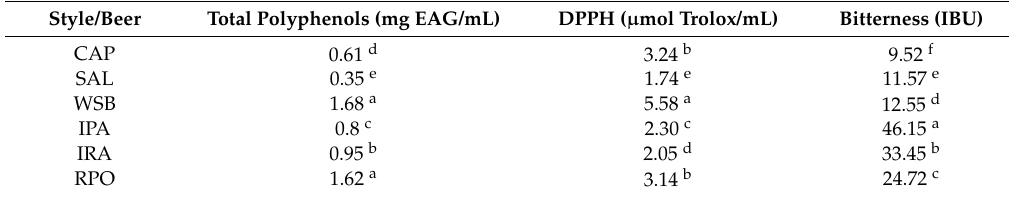
Table 4. Total polyphenols content, antioxidant activity (2,2-diphenyl-1-picrylhydrazyl (DPPH) method), and bitterness value of different craft beers. Classic American pilsner (CAP), standard American lager (SAL), weissbier (WSB), American India pale ale (IPA), Irish red ale (IRA), and robust porter (RPO). Different letters in the same column indicate significant differences between groups of beers ( p < 0.05, ANOVA followed by